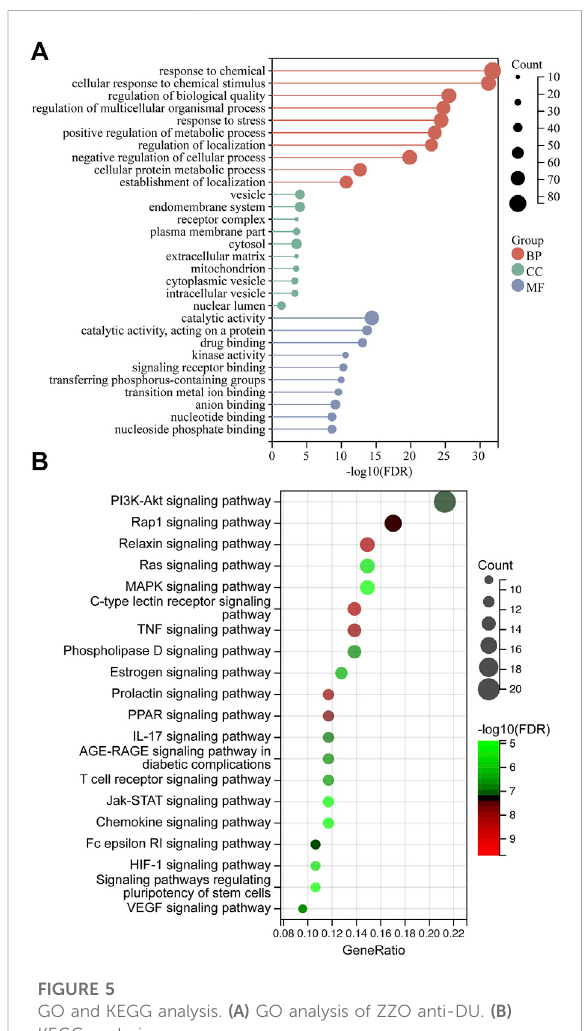
FIGURE 5 GO and KEGG analysis. (A) GO analysis of ZZO anti-DU. (B) KEGG